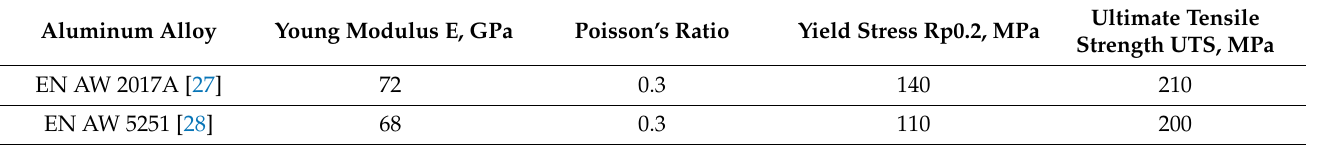
Figure 1. Geometry ( a ) of joints used in numerical/experimental analysis and experimental specimen ( b ) mounted in Endurance Machine. Table 1. Mechanical properties of the materials examined.